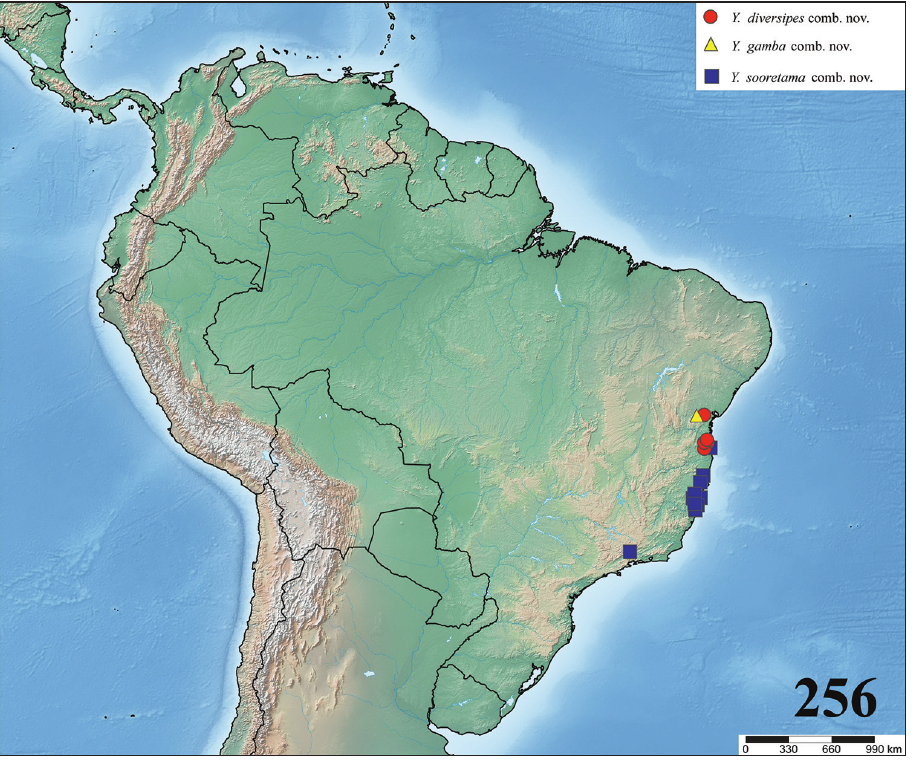
Figure 256. Map showing records of Ybyrapora gen. n. Distribution and habitat. Brazil, in Atlantic rainforest from Bahia to southern Rio de Janeiro (see Bertani and Fukushima 2009, appendix A, fig. 17) (Fig. 256). Key for Ybyrapora gen. n. species Males 1 Embolus length more than 4 times tegulum’s length (Fig. 277) .................... ................................................................................. Y. diversipes comb. n. – Embolus length from 3.0 to 3.5 times tegulum’s length (Figs 261, 269) ..... 2 2 Abdomen dorsum with dark central longitudinal stripe, tegulum with devel- oped prominence, embolus with basal part very curved in frontal view (Fig. 262) .......................................................................... Y. sooretama comb. n. – Abdomen dorsum with red central longitudinal stripe (Fig. 297), tegulum lacking prominence (Fig. 270), embolus with basal part slightly curved in frontal view (Fig. 270) ................................................... Y. gamba comb.